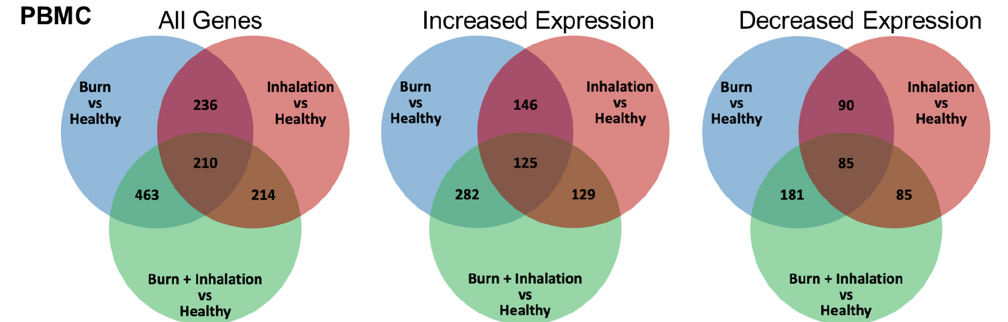
Figure 3. Burn injury, inhalation, and BI injuries induce unique and common gene expression profiles within PBMC. mRNA was isolated from PBMC, which was isolated from burn patients or healthy controls, and gene expression was evaluated using nanostring barcoding (nCounter Human Immune Profiling PanCancer CodeSet; 770 genes, and the Human Metabolic Gene CodeSet; 768 genes). The venn diagrams summarize the number of genes that are significantly ( p < 0.05 using Welch’s t-test after data normalization to housekeeping and internalized the control genes with nSolver v4.0) impacted in a unique or common fashion to each injury type (when quantified versus healthy).